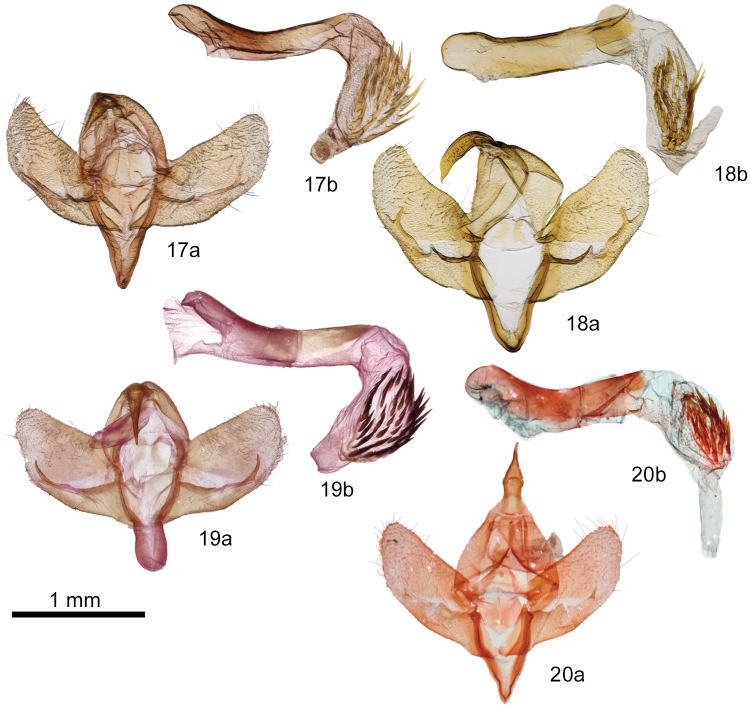
Plagiomimicus male genitalia. 17P.y.yakamaa valves b phallus with everted vesica 18P.yakamamojavea valves b phallus with everted vesica 19P.tepperia valves b phallus with everted vesica 20P.incomitatusa valves b phallus with everted vesica.